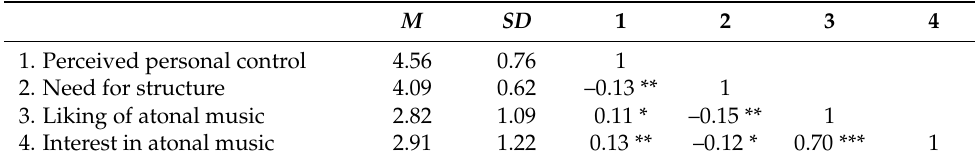
Table 1. Descriptive analysis and